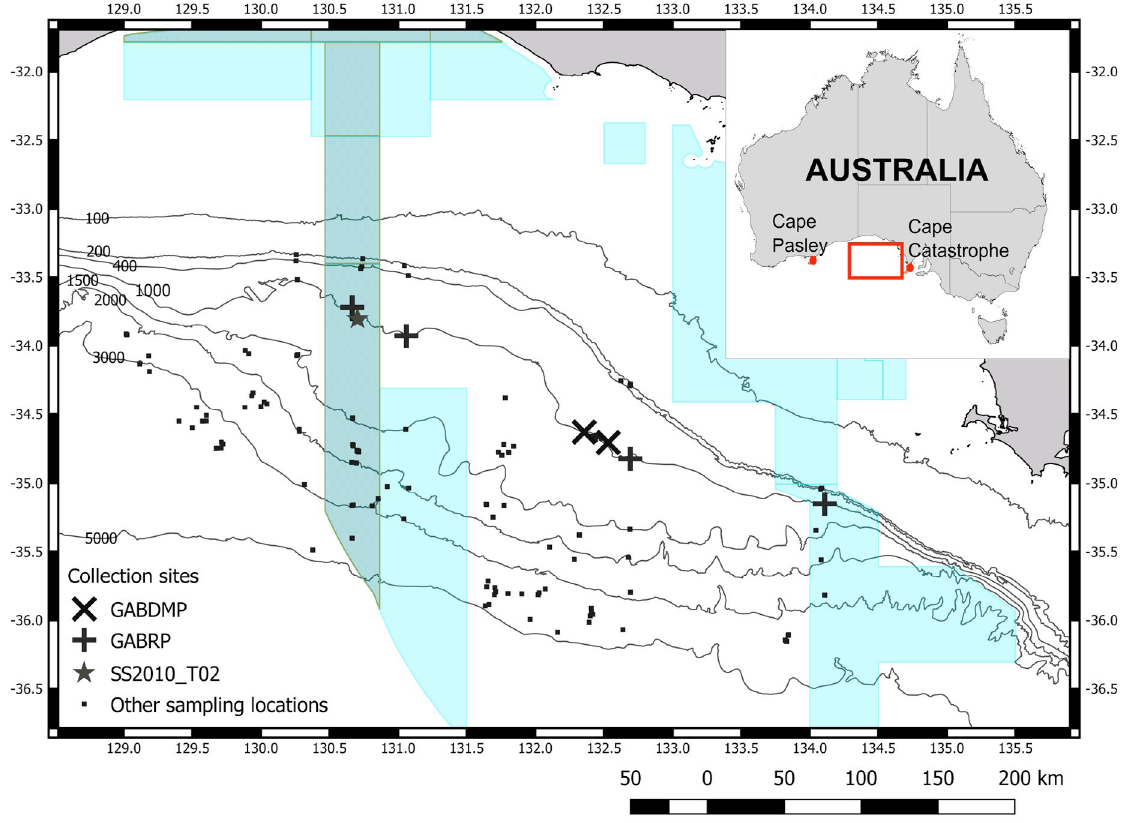
Fig. 1. Sites where Tethya irisae sp. nov. was collected in the Great Australian Bight, including sites that were sampled where the sponge was not found. All specimens of Tethya irisae sp. nov. were collected along the 1000 m contour. Light shaded polygons show the Australian Commonwealth Marine Reserves. The darker polygon strip is the GAB Marine Park Benthic Protection Zone. The 200 m contour is the edge of the continental shelf. Abbreviations: GABDMP = Great Australian Bight Deepwater Marine Program (MNF 2015); GABRP = Great Australian Bight Research Project (Williams et al . 2018). Cruise SS2010_T02 (Currie & Sorokin